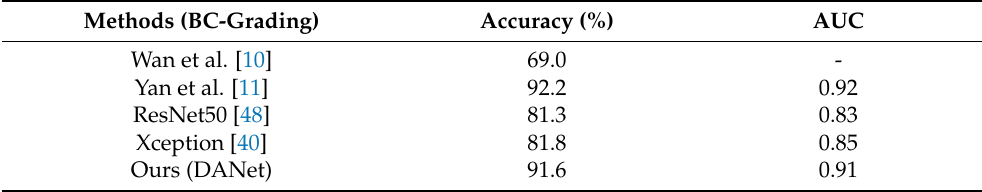
Table 3. Comparison with the previous methods on the BC grading dataset.